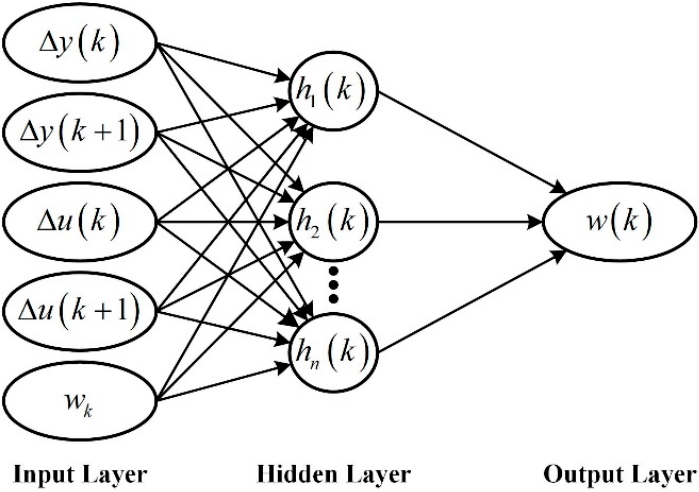
Figure 7. Kernel of MFAC Controller.